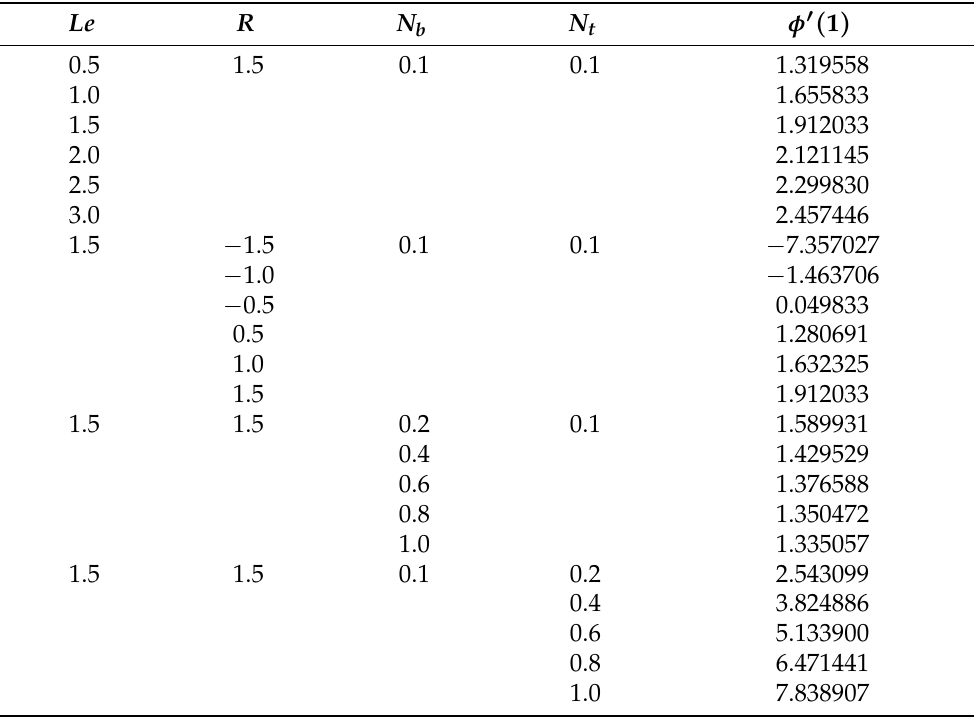
Table 7. Numerical outputs of φ (cid:48) ( 1 ) for Le , R , N b and N t when De = γ = 0.01, Ha = δ = Ec = 0.1, S = Da = 1 and γ 1 = Pr =